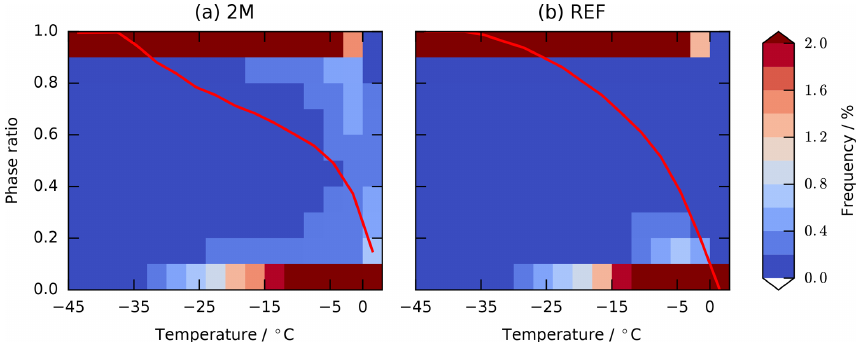
Figure 7. Frequency of cloud occurrence per temperature and phase ratio for histogram bin widths of 3 ◦ C and 0.1, respectively. The average ice fraction per temperature bin is shown by the red line for the new model (2M; a ) and the reference model (REF; b ). The data have been accumulated over 10 years of simulation from 2003 to 2012.